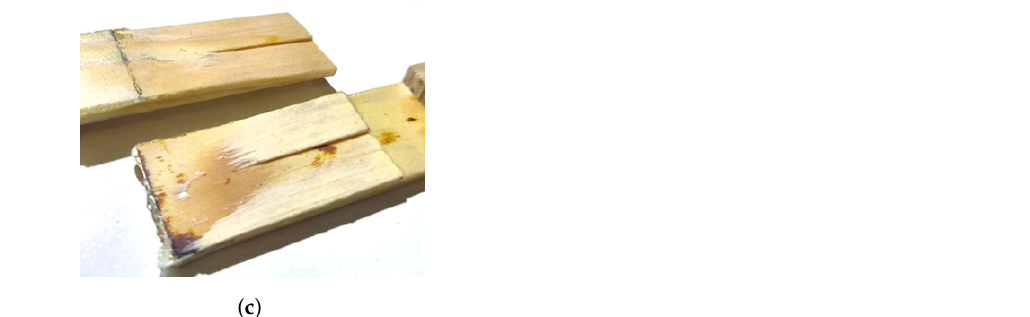
Figure 17. Failure mechanisms at different cross-head rates for W joints. ( a , b ) High cross-head rate (6 m/min). ( c ) Impact (60 m/min).